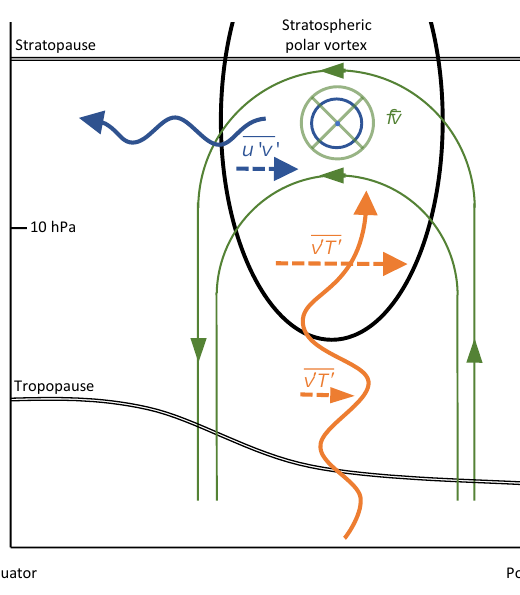
Figure 1. Schematic illustration of the dominant forcing terms of the momentum budget in the Eulerian framework during SSW events and their underlying dynamical processes. Planetary-scale waves propagate upward (orange) from the troposphere to the stratospheric polar vortex (thick black line) and are accompanied with poleward heat fluxes ( v (cid:48) T (cid:48) ) amplifying with height. In agree- ment with the Matsuno (1971) model, the poleward heat fluxes gen- erate a thermally direct circulation (green) with air rising at the pole and sinking in the mid-latitudes. To close this circulation, equator- ward motion is generated in the stratosphere. The Coriolis torque resulting from this circulation decelerates the wind (into the page symbol). Equatorward wave propagation is also observed (blue), ac- companied with poleward fluxes of westerly momentum ( u (cid:48) v (cid:48) ). The resulting convergence of momentum fluxes in the polar stratosphere acts to accelerate the zonal-mean zonal wind (out of the page sym- bol), counteracting partly the deceleration by the Coriolis torque. Note that in the transformed Eulerian mean the residual circulation is opposite, i.e., poleward in the stratosphere and downward at the pole. The residual circulation approximates Lagrangian-mean mo-